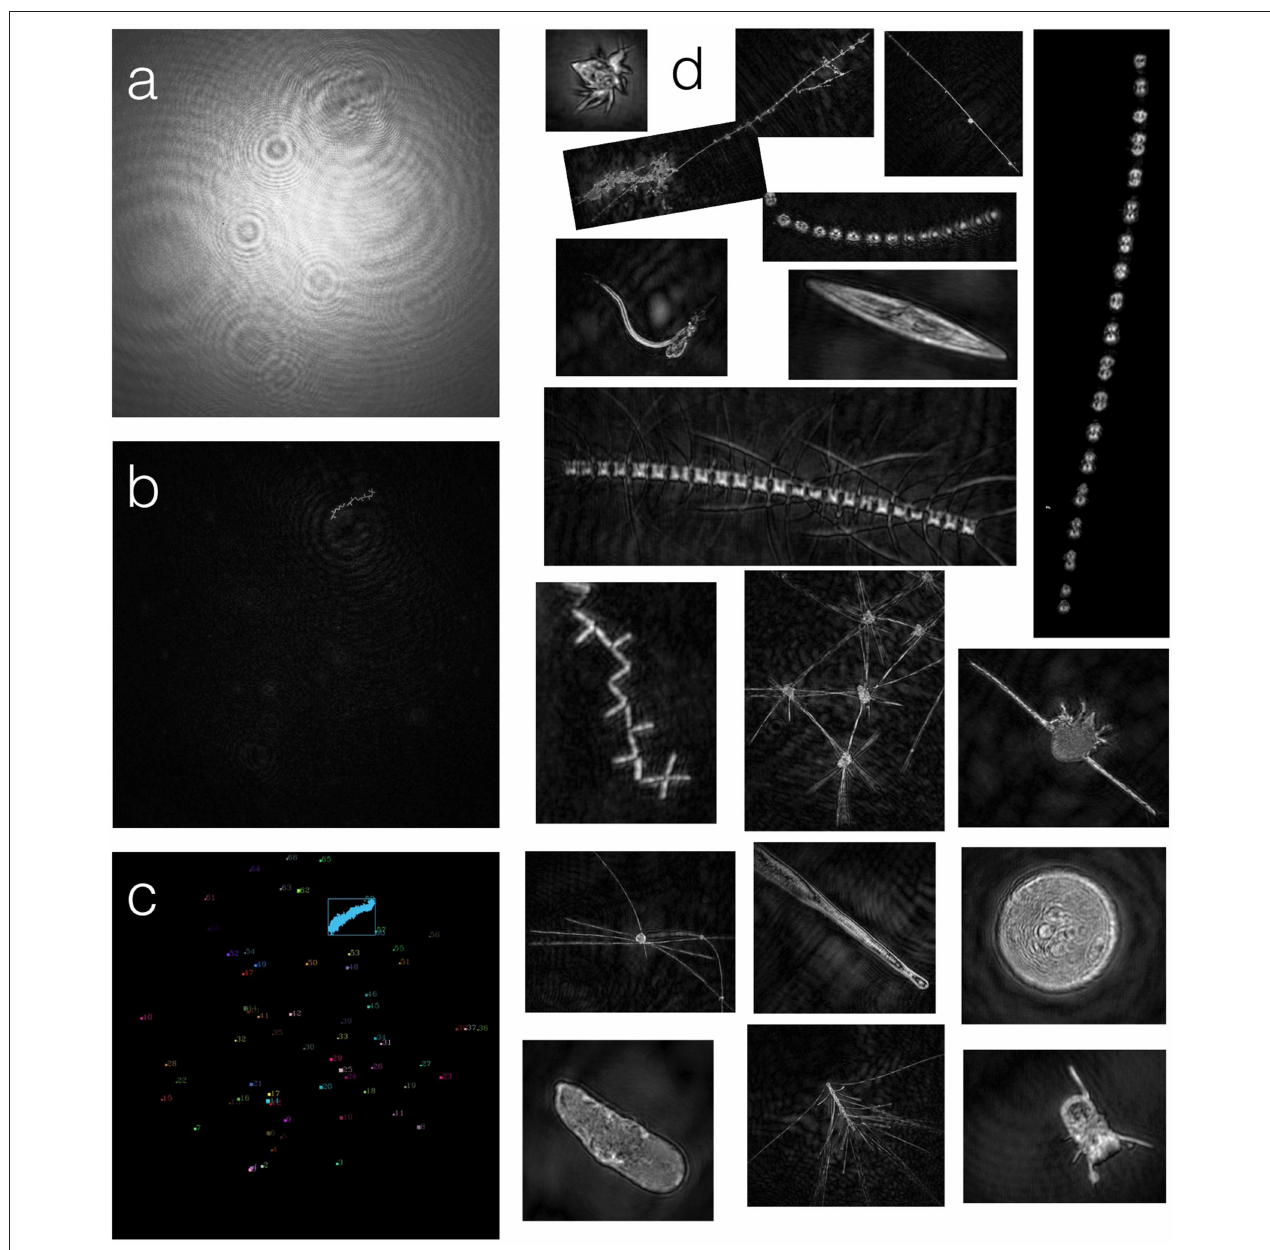
FIGURE 4 | The custom hologram processing pipeline extracts 2D contours from the imaged 3D volume. (a) A raw 2D hologram. (b) A refocused hologram image at 16,250 µ m from the laser source, revealing a Thalassionema type chain-forming diatom. (c) Regions of interest (colored and sorted) derived from the image processing pipeline (d) An assortment of re-focused hologram contours illustrate the variety of marine particle types imaged by the holographic microscope, including diatoms, detritus, and